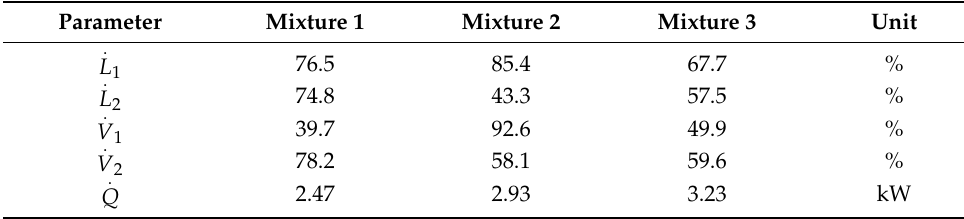
Table 8. Characteristics of the initial operating points of all